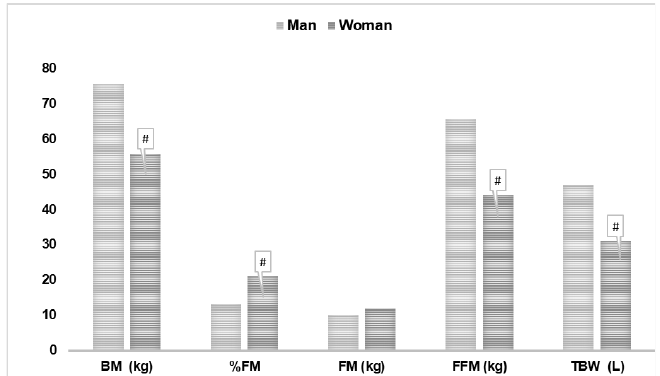
Figure 2: Major components of the body composition assessment for high-performance karate athletes through bioimpedance (fat-free mass, fat mass and total body water) in the sample and between sexes. BM (body mass); %F (fat percentage); FM (fat mass); FFM (fat-free mass) and TBW (total body water). # statistically different between